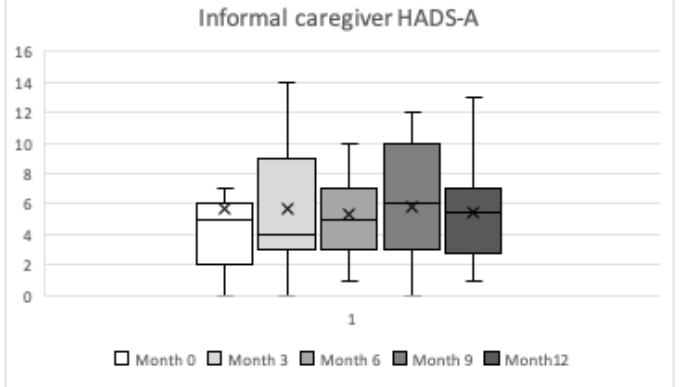
Figure 5. Informal caregivers’Hospital Anxiety and Depression Scale-A during the year observation period (minimum, quartile 1, median, quartile 3,